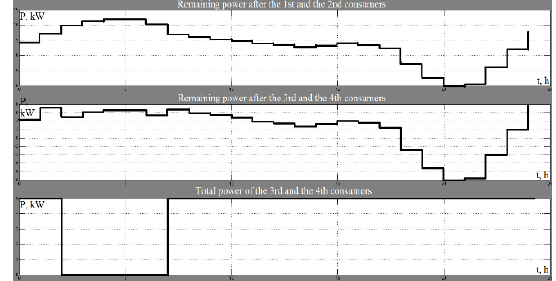
Figure 6. The graphs of calculation results